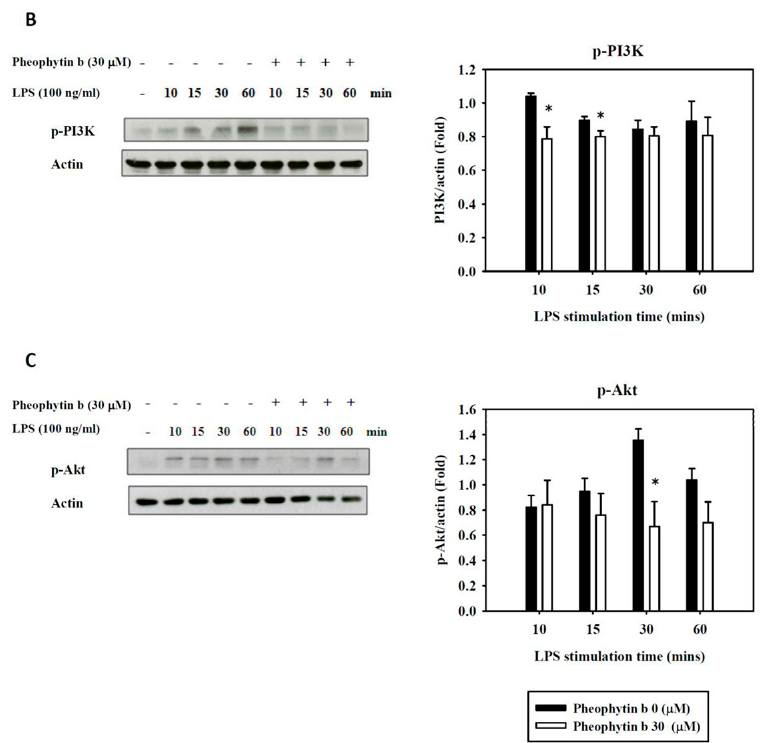
Figure 7. Effects of pheophytin-b on the STAT1 and PI3K/Akt pathways in LPS-stimulated RAW 264.7 cells. Western blot analysis of STAT1 ( A ), PI3K ( B ), and Akt ( C ) phosphorylation induced by LPS (100 ng/mL) was significantly suppressed by pheophytin-b. Cells were pre-treated with 30 µ M pheophytin-b for 30 min, and total protein was harvested at four different time points (10, 15, 30 and 60 min) after LPS stimulation (100 ng/mL). * p < 0.05 vs. cells treated with LPS alone (Student’s t -test, n = 3).